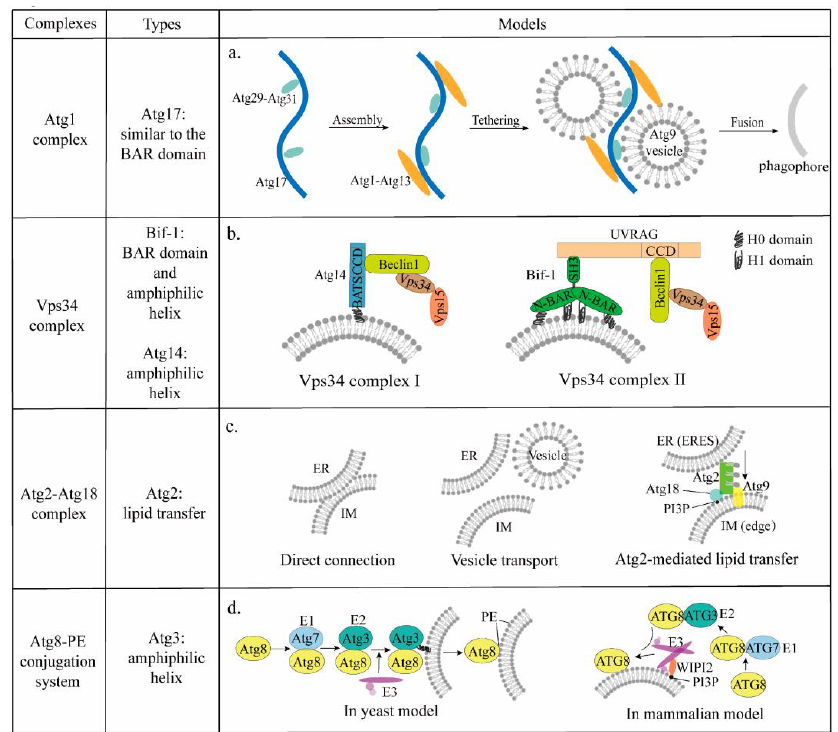
Figure 2. The different types and models to explain the mechanisms inducing membrane curvature. ( a ) Atg17 of the Atg1 complex senses membrane curvature and tethers Atg9 vesicles through its BAR-like domain. ( b ) Left: Atg14 recruits Beclin1 to produce PI3P to promote the autophagic process. Right: Bif-1 of the Vps34 complex affects autophagy by tethering Atg9 vesicles through the BAR